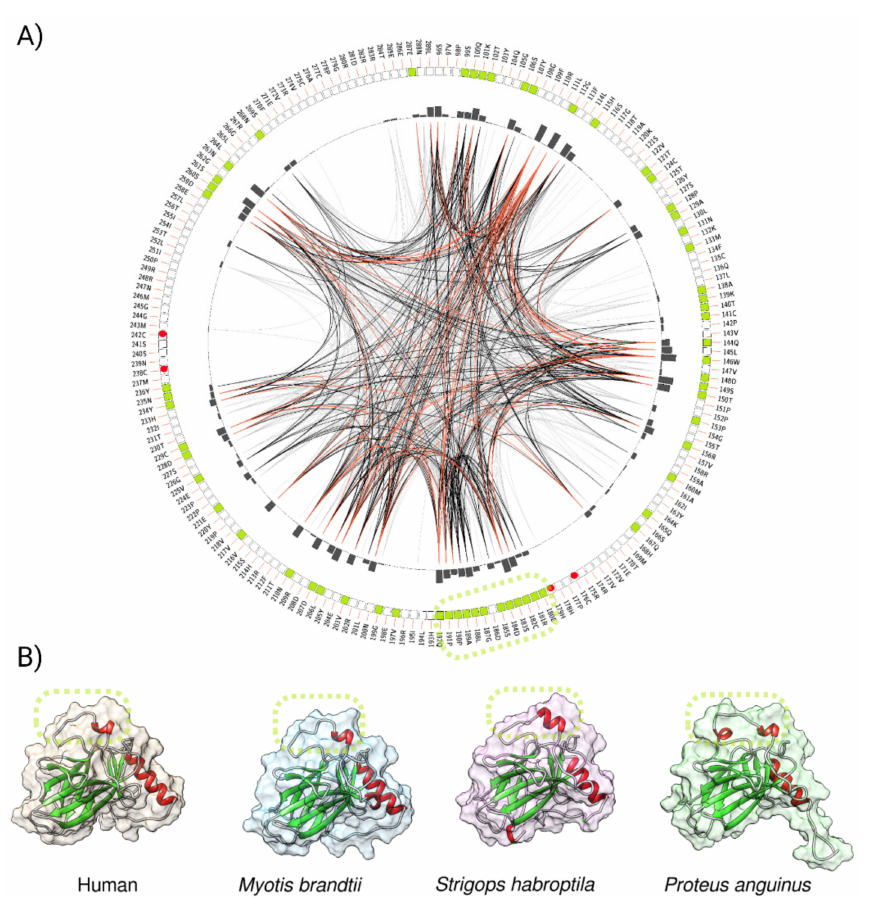
Figure 8. A graphic representation of the positions of the p53 amino acids’ linked to longevity in the animal kingdom. ( A ) Mutual information to infer the convergent evolution of p53 core domains. A circos plot is a sequential circular representation of the multiple sequence alignment and the information it contains. Green boxes in the outer circle indicate the positions of the amino acids’ changes correlating with longevity. The dashed oval highlights the longest region associated with longevity, which spans the loop 2 (L2, residues 180–192) region of human p53 DBD including S185. Lines connect pairs of positions with mutual information greater than 6.5 [51]. Red edges represent the top 5%, black represents between 70 and 95%, and gray edges account for the remaining 70%. ( B ) p53 core domains of three different, long-lived organisms compared to humans, as modeled by